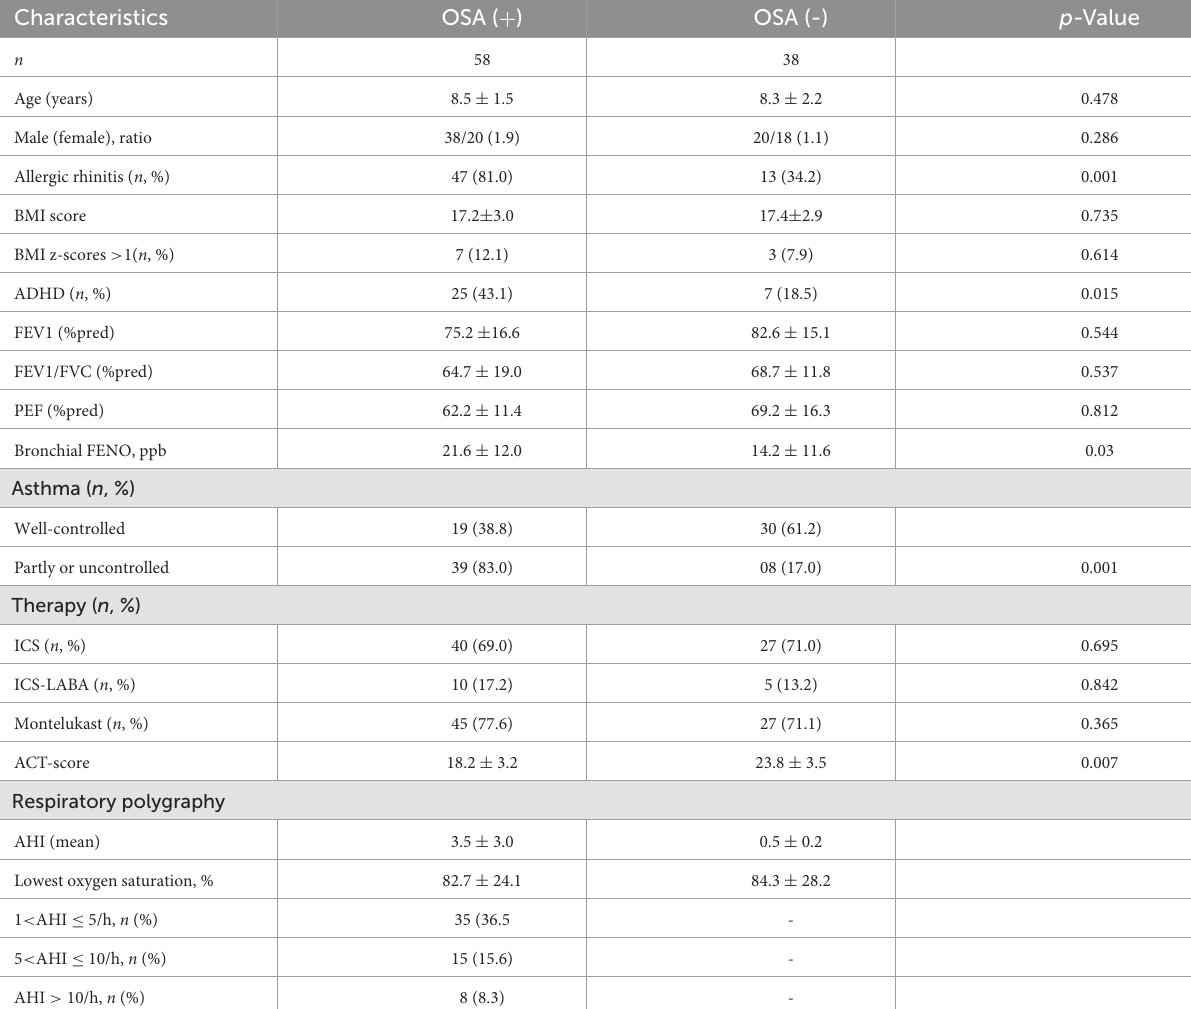
TABLE 2 Demographic characteristics and asthma control levels of the study subjects classified by OSA. Characteristics OSA ( +